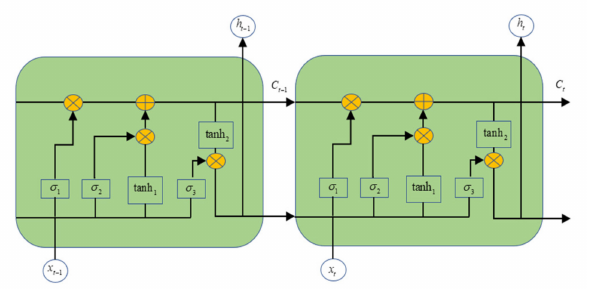
Figure 4. LSTM basic